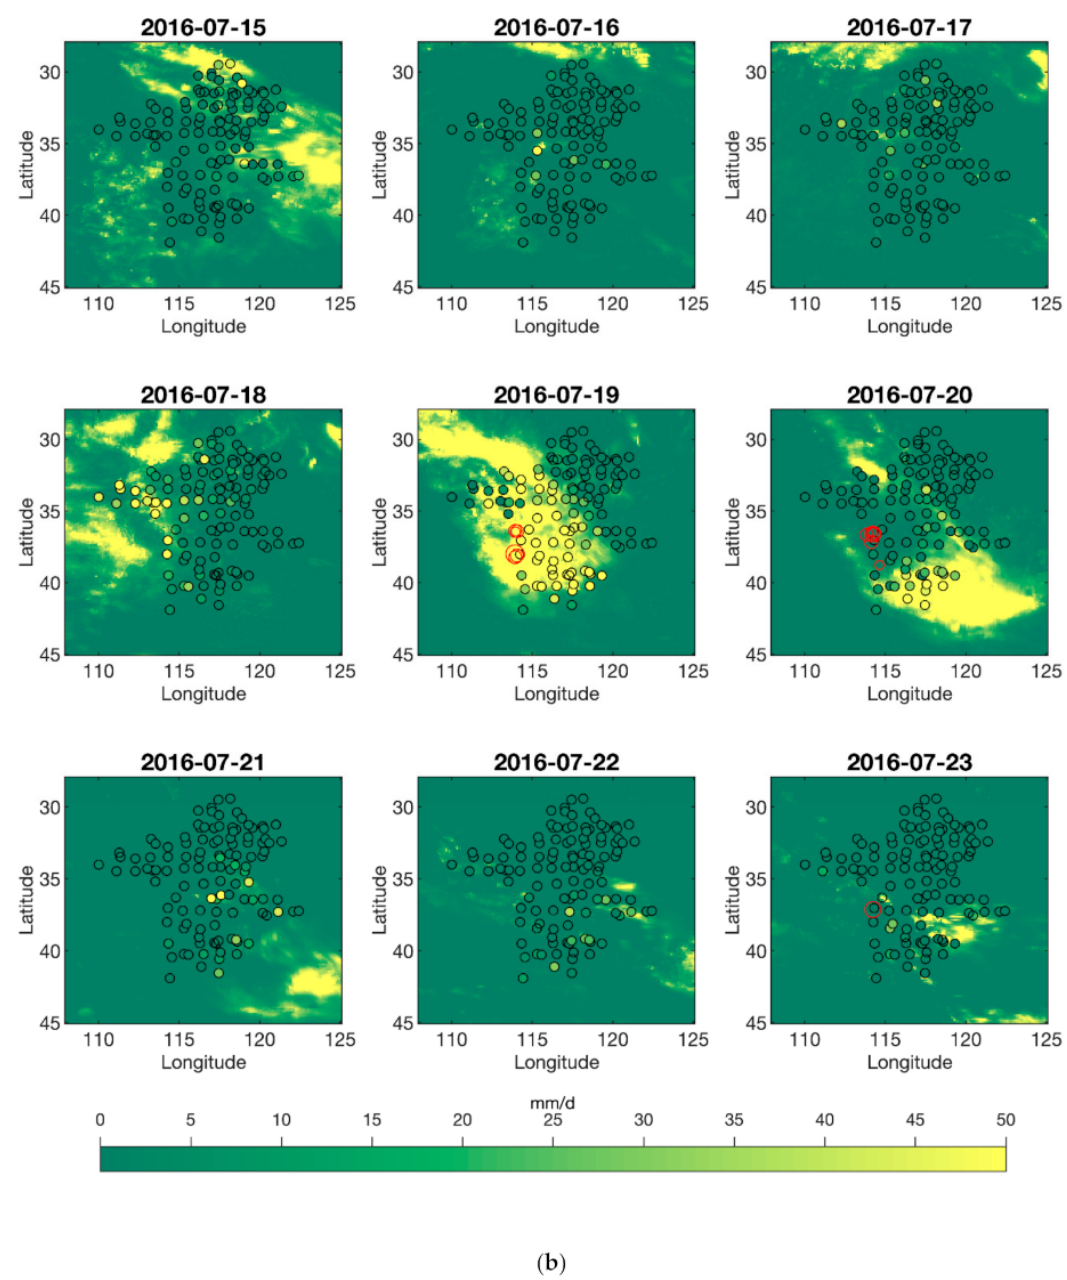
Figure 13. The distribution of precipitation and floods. The background is the precipitation of the corresponding IMERG products. The black, color filled dots are station observed precipitation. The red circles are flash flood events. ( a ) hazard_dailyP_cal, IMERG-F. ( b ) hazard_dailyP_uncal,